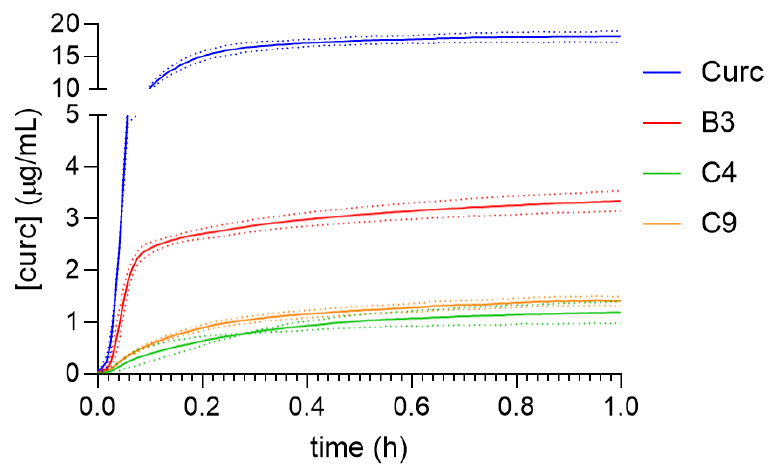
Figure 9. In vitro drug release profiles of curcumin powder and curcumin-loaded hydrogel made of SF and SF/HA with different mass